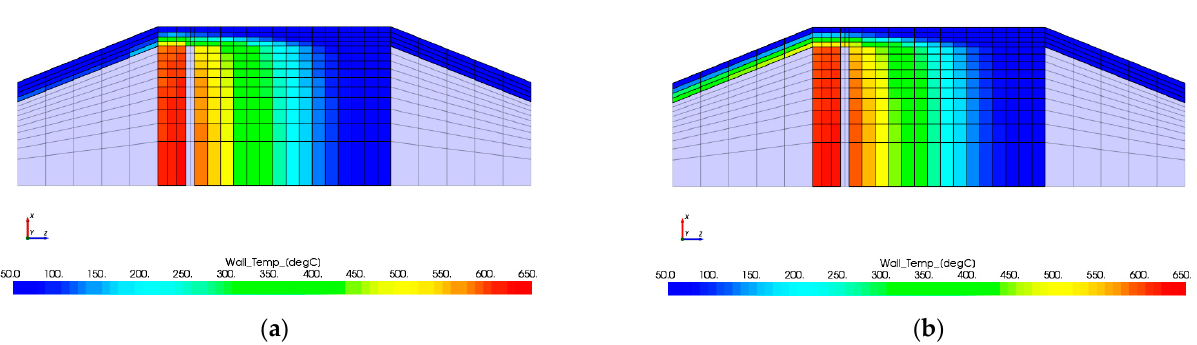
Figure 13. Contribution of radiative heat transfer. ( a ) Heat transfer through conduction and convection; ( b ) Heat transfer through conduction, convection, and radiation.